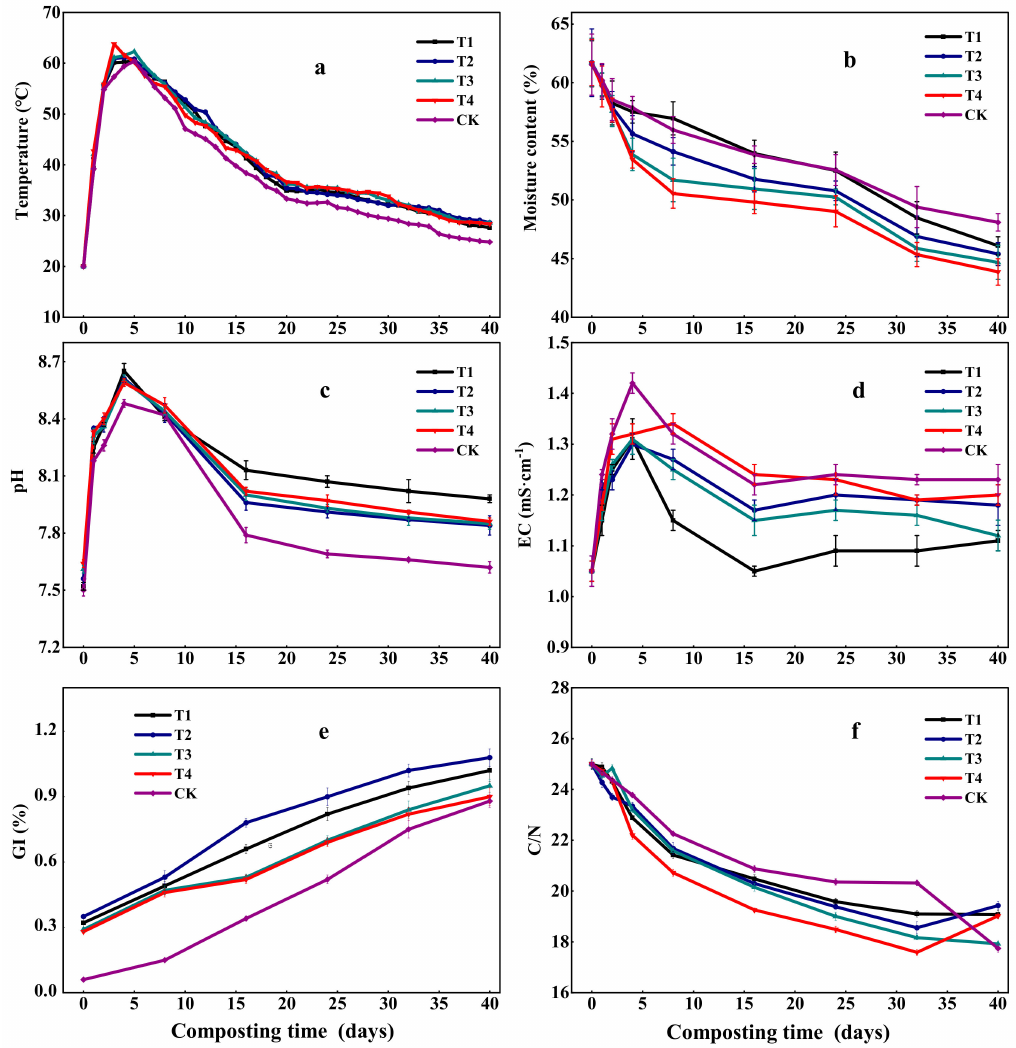
Figure 2. Variations of temperature ( a ), moisture content ( b ), pH ( c ), EC ( d ), GI (e), and C/N ( f ) of different treatments during the composting